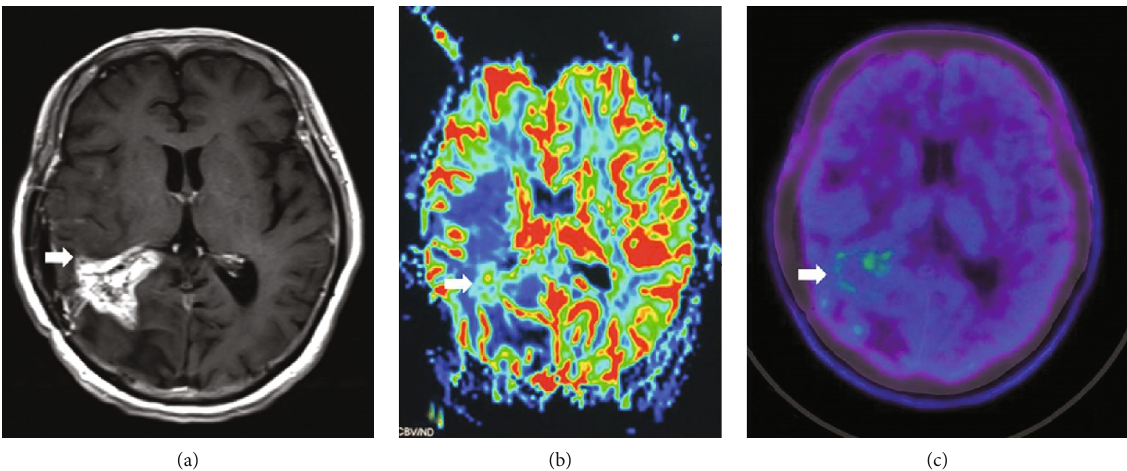
Figure 6: MET PET with PWI of radiation necrosis. Contrast-enhanced T1-weighted MR image (a) and relative CBV map (b) and MET PET/CT image (c) for a 44-year-old man with necrosis. The lesion in the right parietal lobe (arrow) shows enhancement (a) and negative fi ndings on both the rCBV map (b) and the MET PET/CT image (c). Reproduced with permission from Figure 3 of Qiao et al.